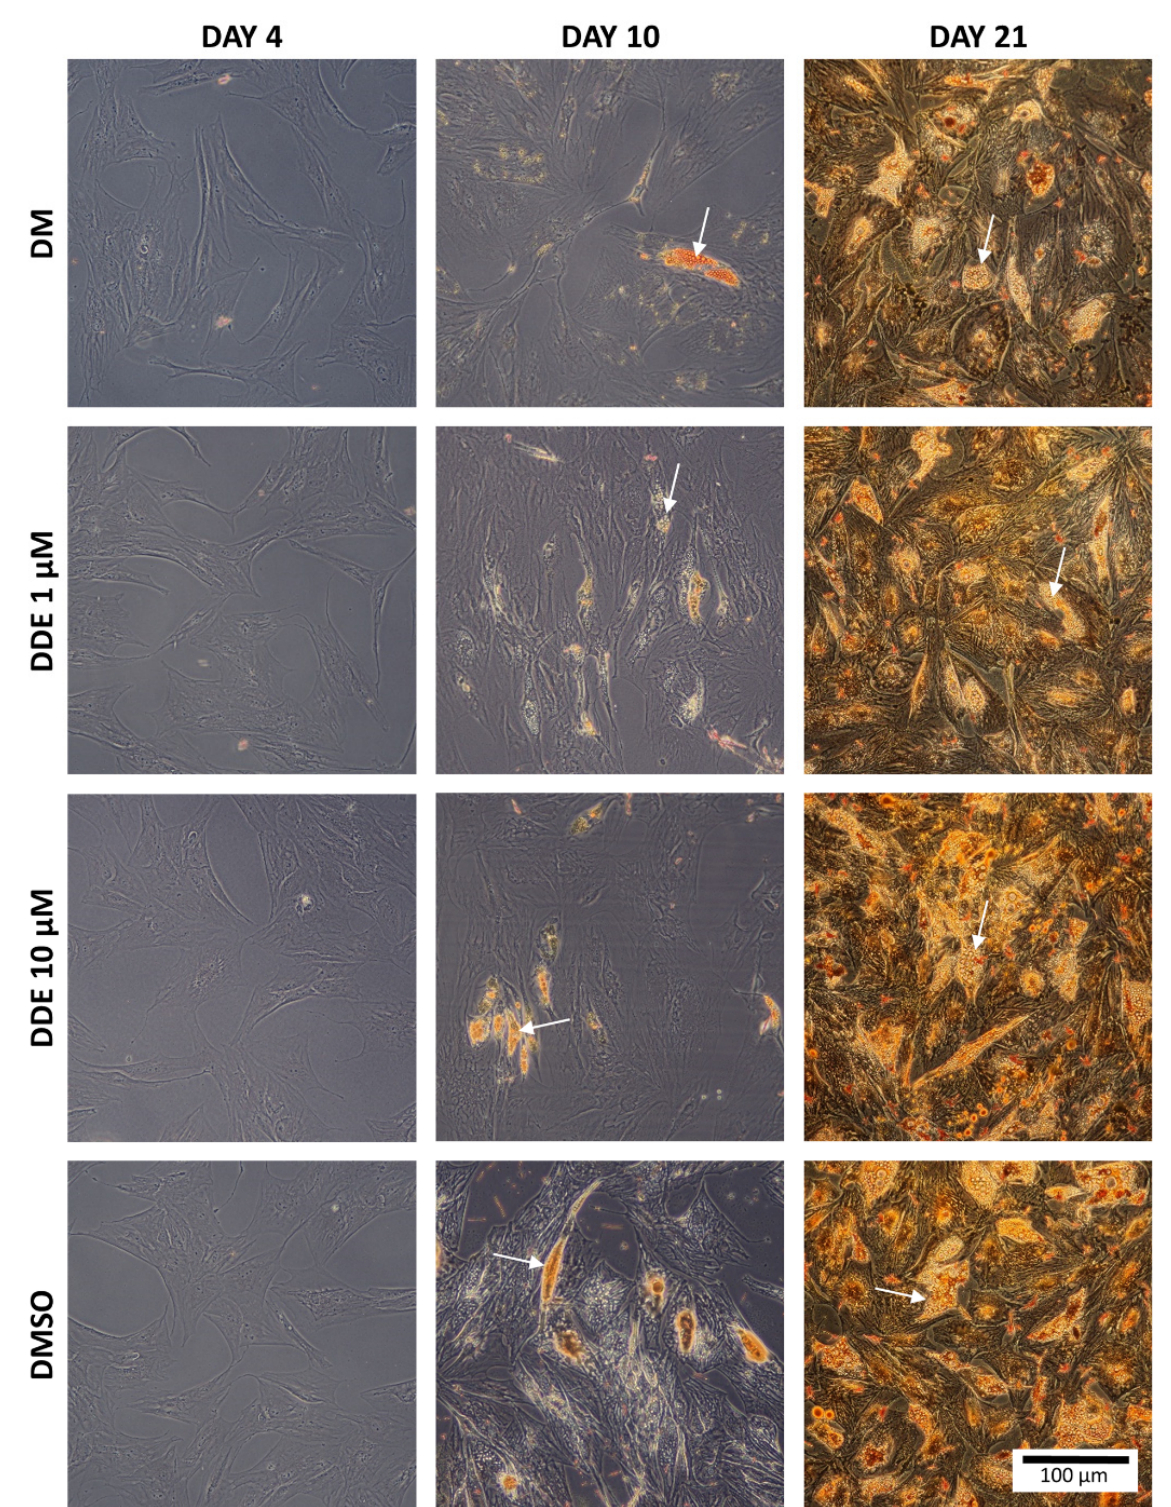
Figure 3. The comparison of fat in each environment. The arrows show examples of fat droplets. (Oil Red O staining).